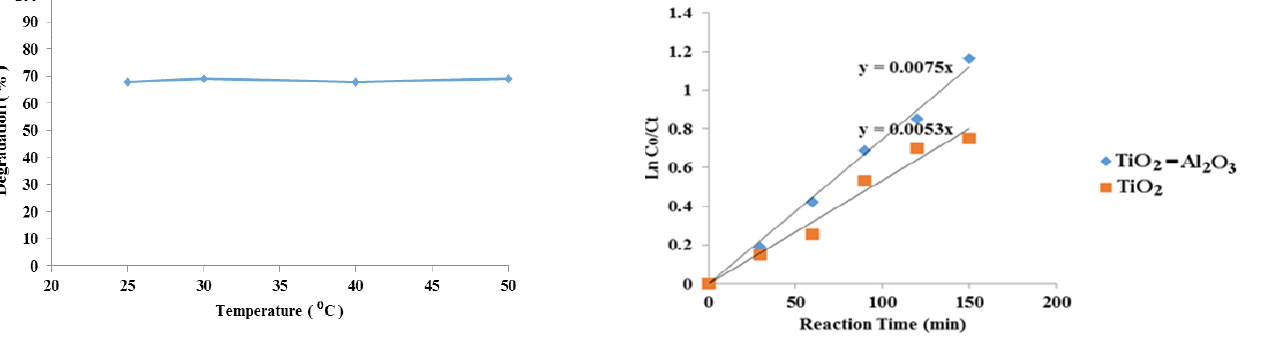
Fig. 10. Comparison results between the catalytic activities of TiO and TiO -Al O 2 2 2